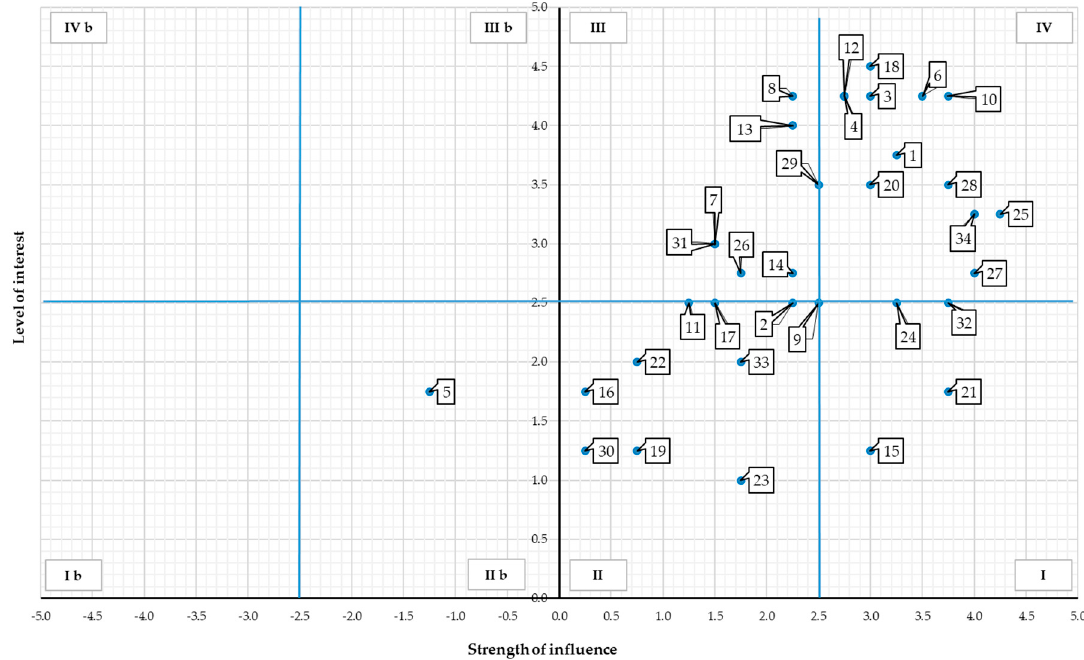
Figure 6. Stakeholder map in the innovation ecosystem: strength of influence—level of interest.